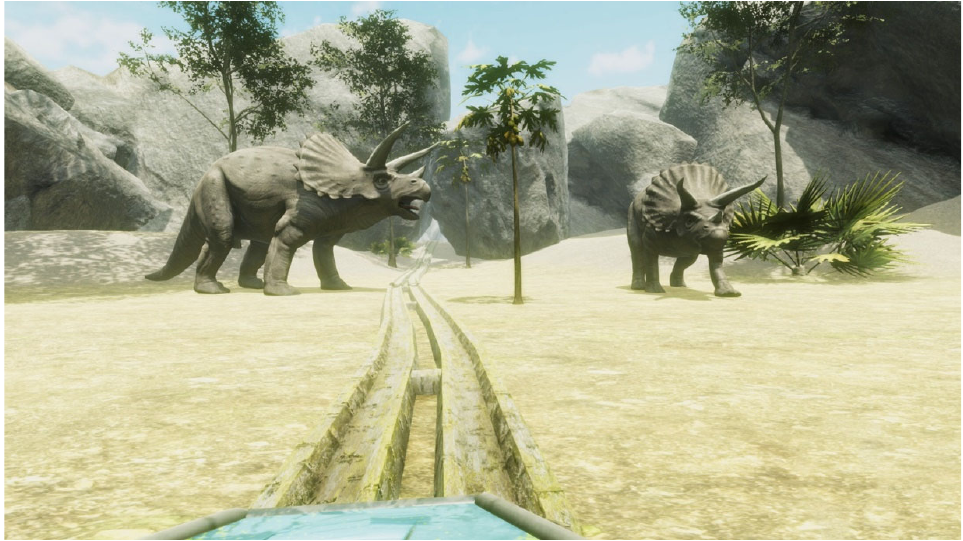
Figure 1. Example images from «Epic Roller Coaster» by B4T Games Scenario «T ‐ Rex Kingdom»; reproduced with permission.